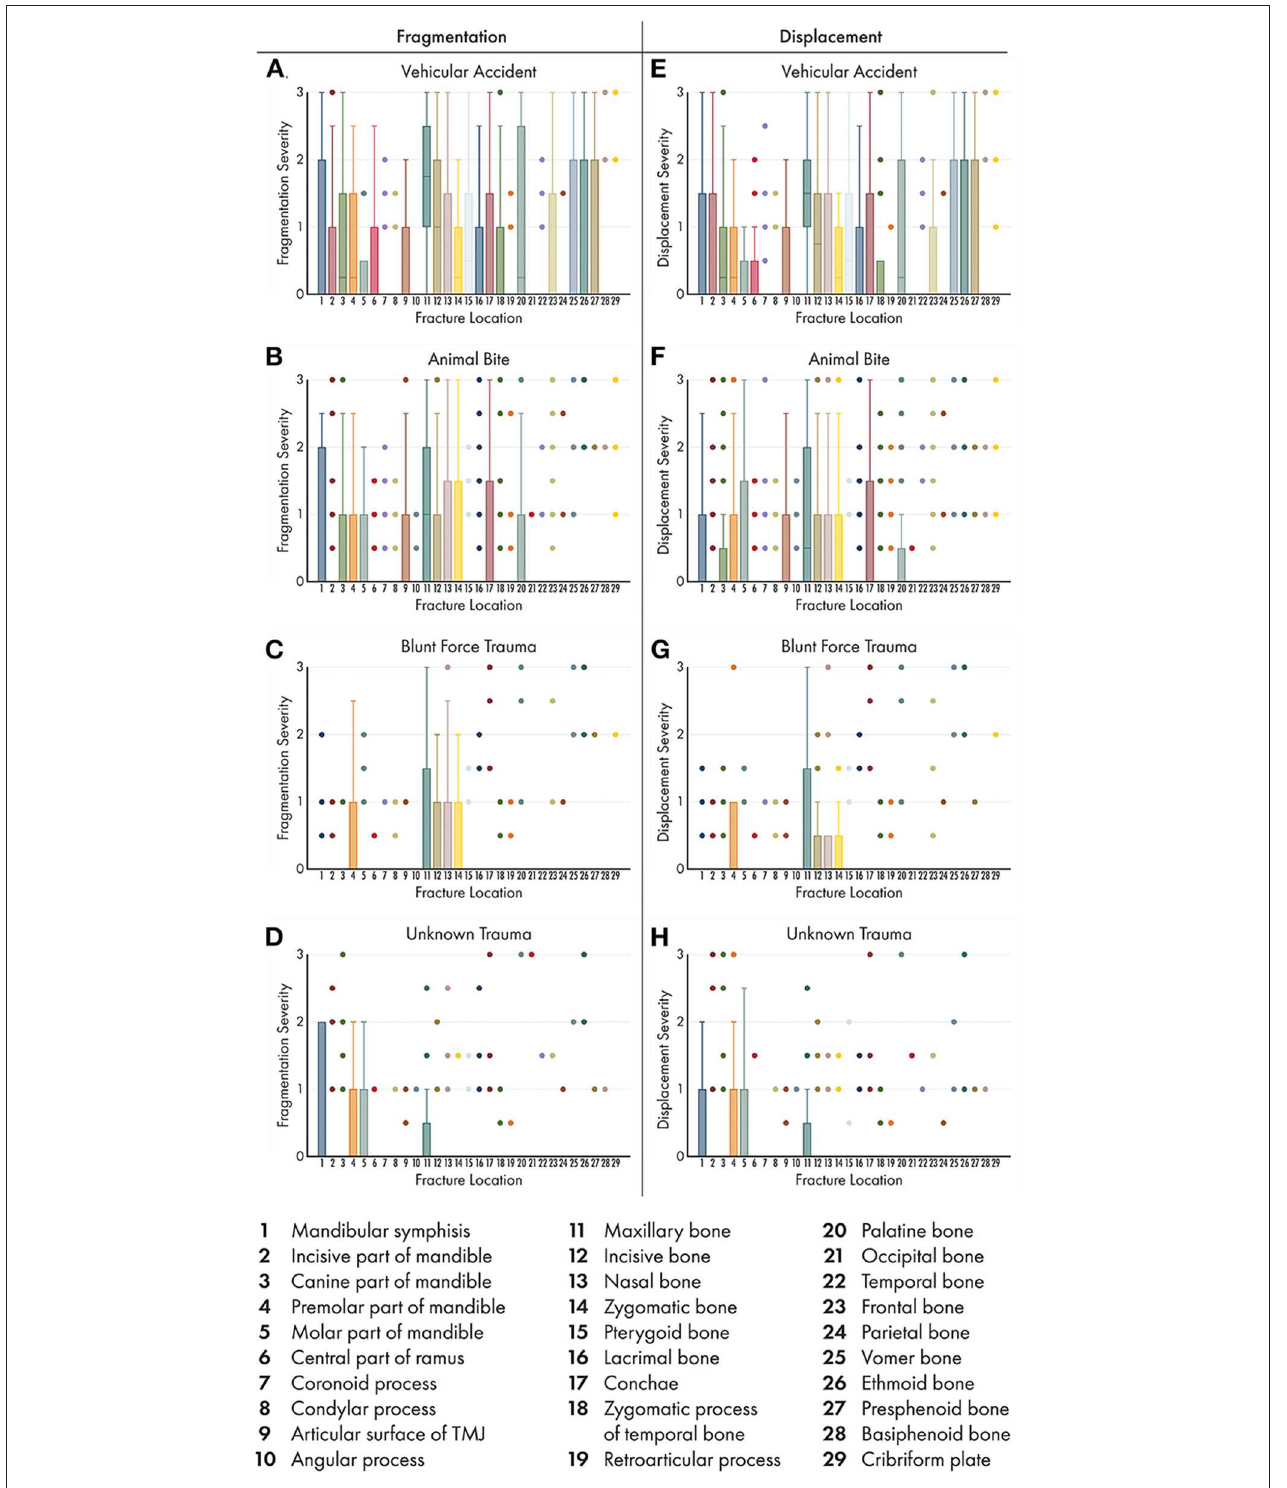
FIGURE 13 | Box and whisker plots of fracture morphology by trauma etiology and fracture location. Box and whisker plots were used to demonstrate the severity of fragmentation (A–D) and displacement (E–H) of fractures occurring at each location based on trauma etiology. As in part I of this study, only those trauma etiologies that occurred in > 20 cases were included for analysis. Boxes and whiskers represent the majority of the fractures recorded. Colored dots indicate outliers in the data. Therefore, locations with only colored dots visible indicate that the fragmentation and severity score was 0 (the locations were not fractured) the majority of the time. No attempt was made to determine significance in patterns across